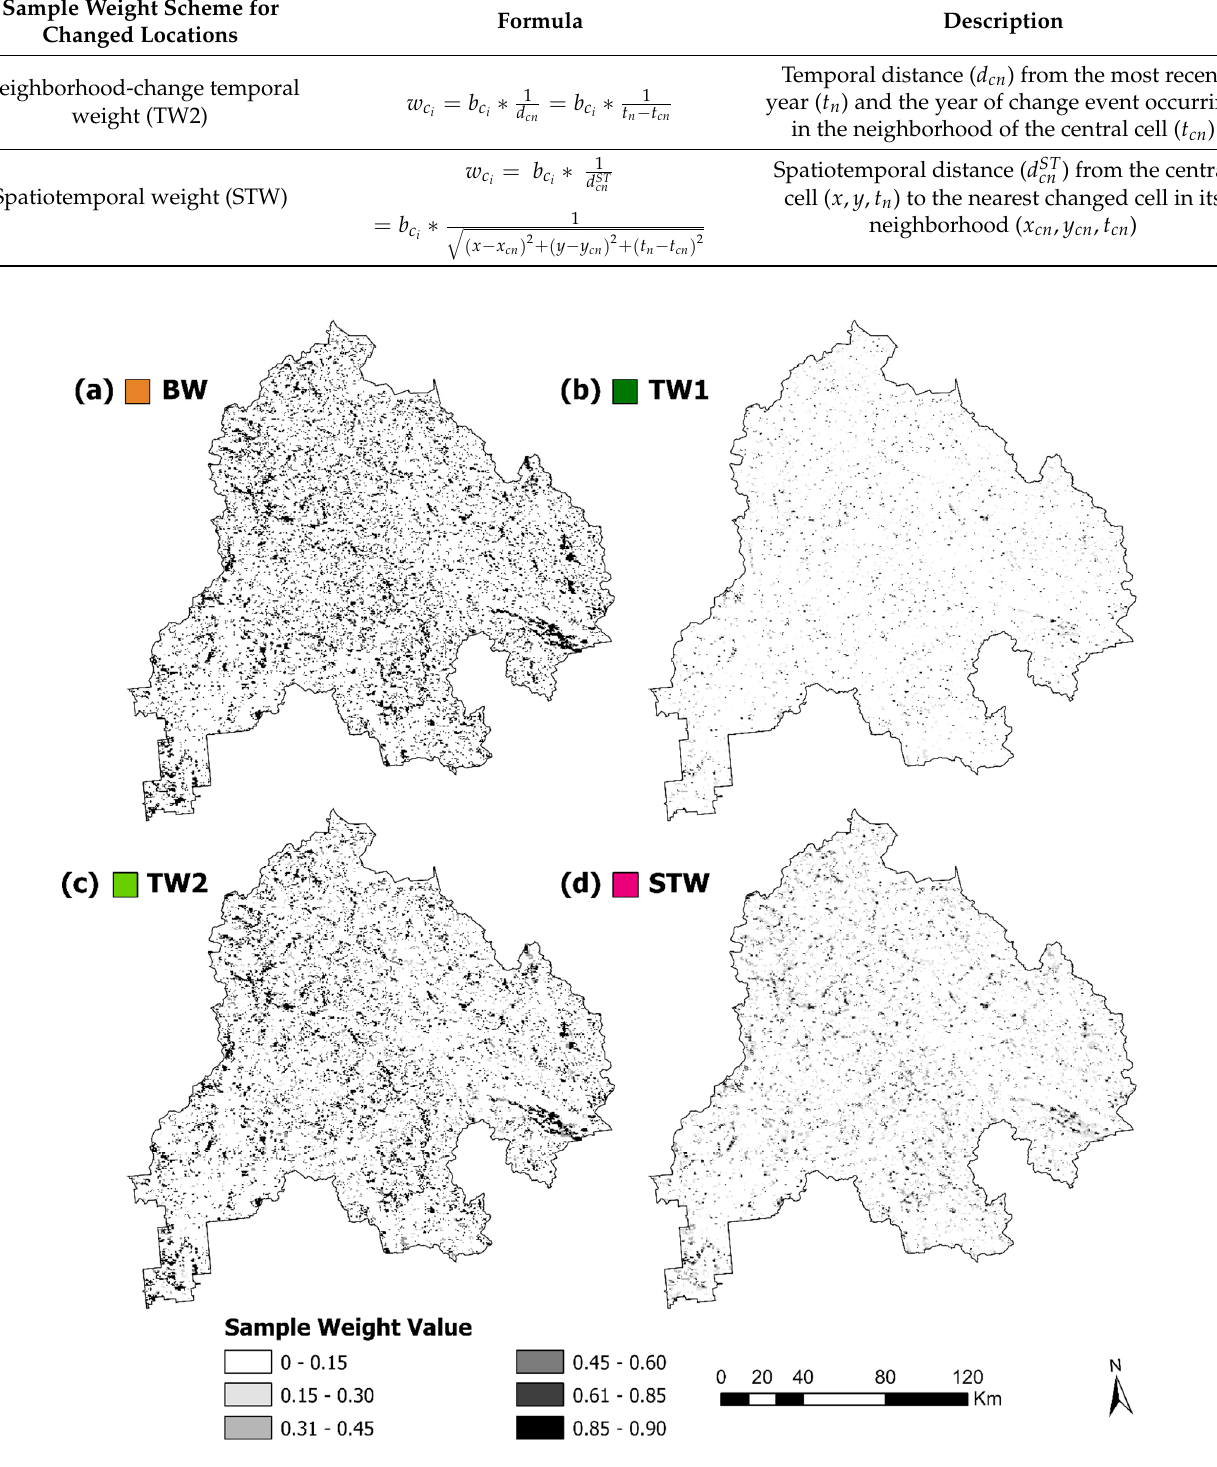
Figure 3. Maps depicting the variation of sample weights under each weighting scheme. The sample weights assigned to every location represent ( a ) binary weight (BW), ( b ) cell-change temporal weight (TW1), ( c ) neighborhood-change temporal weight (TW2), and ( d ) spatiotemporal weight (STW). Color swatches adjacent to each sample weight scheme correspond to those used in figures in subsequent sections.